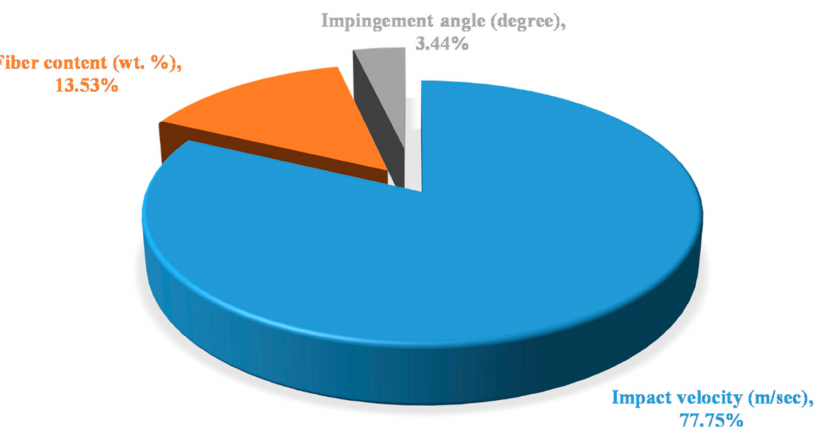
Figure 9. Contribution chart of factors for polyester based composites.